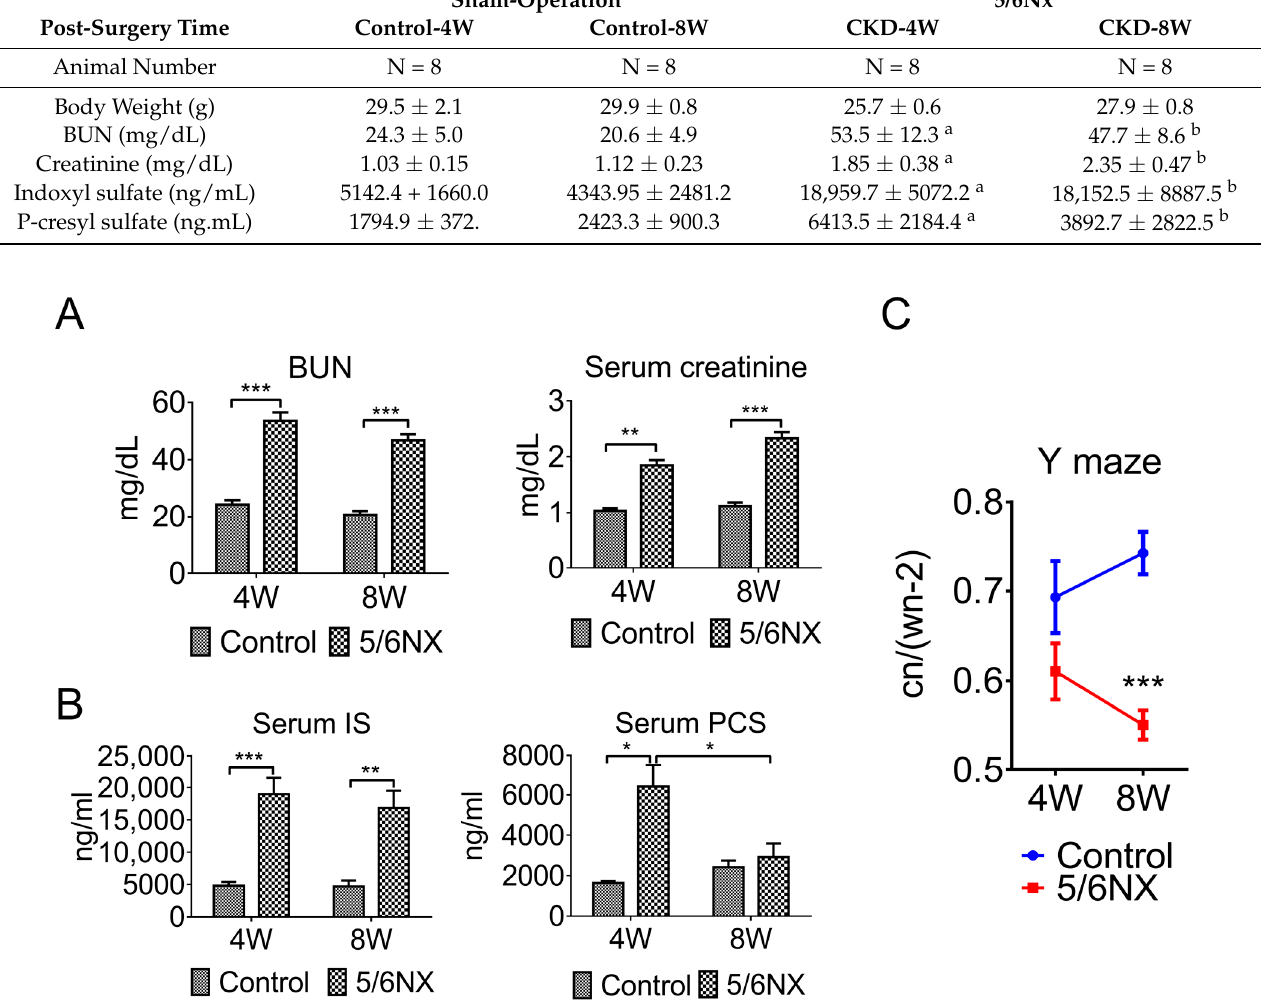
Figure 2. The 5/6 nephrectomy-induced chronic kidney disease (CKD) mouse models show impaired working memory. The serum levels of BUN (panel ( A )), creatinine (panel ( A )), and indoxyl sulfate (IS, panel ( B )) of the 5/6 nephrectomy mice were significantly higher than those of sham-control mice at 4 and 8 weeks. However, p-cresol sulfate (PCS) levels significantly increased at week 4 but dropped back at week 8 (panel ( B )). These findings suggest that the 5/6 nephrectomy procedure could successfully establish CKD animal models. The Y-maze behavioral test was performed at 4 and 8 weeks after the 5/6 nephrectomy procedure to examine working memory, which is also referred to as hippocampal function (panel ( C )). The Y-maze test revealed significantly decreased cognitive function compared with the sham control group at 8 weeks after 5/6 nephrectomy surgery. Wn (walking number): number of times the animal passes different arms within 5 min; Cn (cycle number): number of times the animal goes through the three arms (n = 8, * p ≤ 0.1; ** p ≤ 0.01; *** p ≤ 0.001).